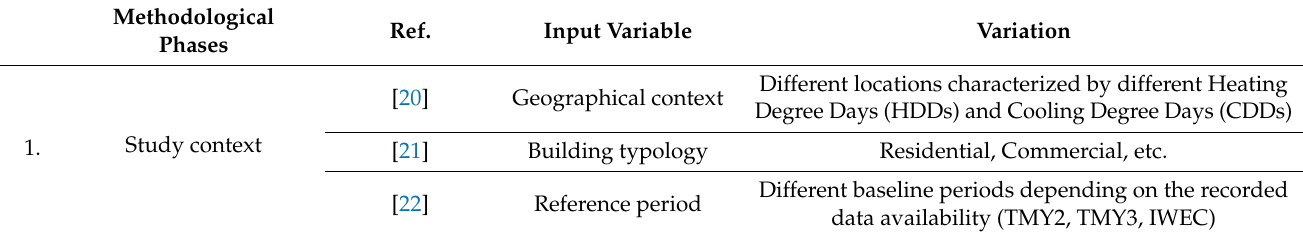
Table 1. Methods to evaluate climate change impacts on building energy consumption.